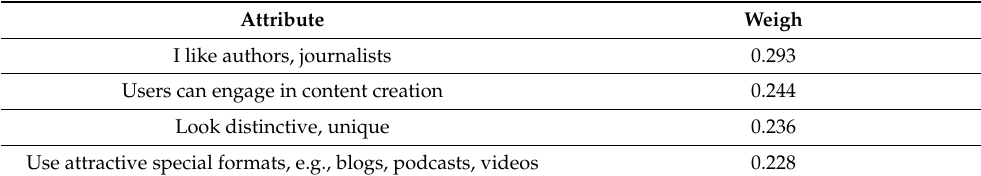
Table 12. Significant delfi.lv brand attributes that contribute to brand uniqueness, weights, and